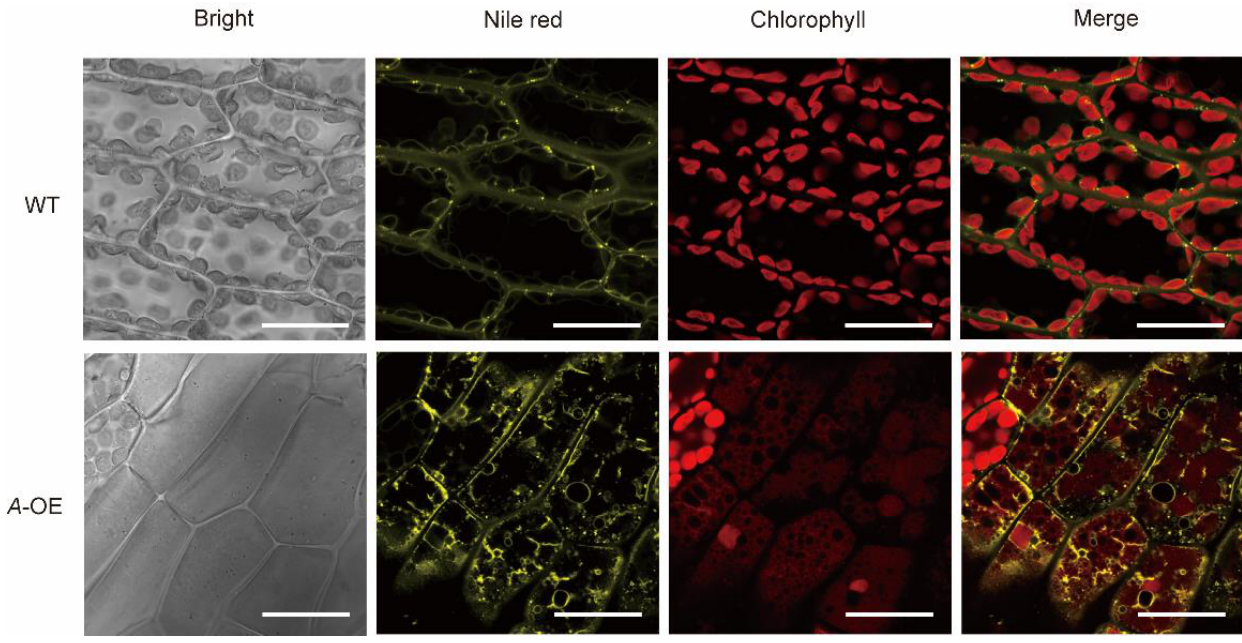
Figure 4. Accumulation of lipid droplets in WT and A -OE under normal growth conditions. Scale bar = 20 μm.